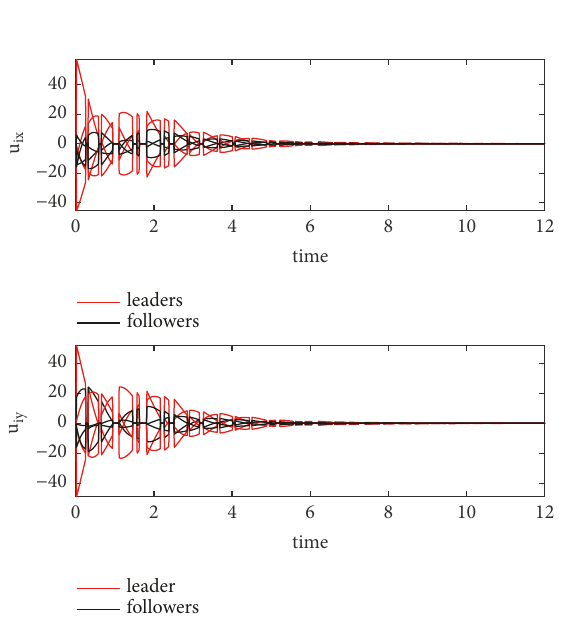
Figure 5: The velocity states of eight agents.